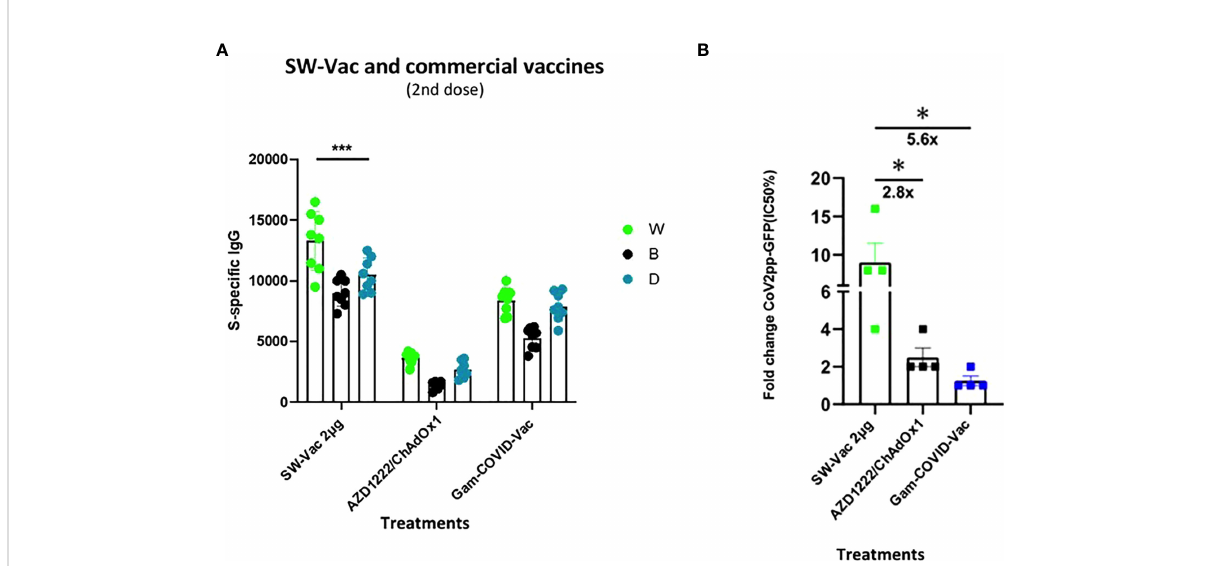
FIGURE 4 Anti-spike IgG titers and neutralization titers induced by S-Vac formulation and commercial vaccine in mice. BALB/c mice (n=8/group) were immunized on Days 0 and 14 with formulations containing spike puri fi ed protein from ancestral Wuhan (2µg) or commercial Gam-COVID-Vac- rAd26/rAd5 or AZD1222/ChAdOx1 vaccines delivered intramuscularly. Serum collected on Day 14 was analyzed by ELISA to determine the levels of S-speci fi c IgG. Sera titers were obtained by plotting the OD 492 nm vs. log curve of the reciprocal of the dilution in the GraphPad Prism program. Titers of Panel (A) are expressed as the inverse of the in fl ection point dilution of the curve. For statistical analysis, antibody titers were log-transformed and then analyzed by a one-way ANOVA with Bonferroni ’ s multiple comparisons test. For all treatments, the titers detected after the second dose were signi fi cantly different from those found after the fi rst dose (p<0.0001). Neutralizing titers were measured by 50% inhibition for the pseudotyped virus (CoV2pp-GFP) in immunized and non-immunized mice (B) . Absolute inhibitory concentration was calculated as the corresponding point between the 0% and 100% assay controls. Fifty % inhibition was de fi ned by the controls for all the samples on the same plate. Data in panel (B) is presented as the fold change of CoV2pp-GFP related to the minimum value detected in immunized animals. For statistical analysis, one-way ANOVA with Bonferroni`s multiple comparisons test was used. *p<0.05;